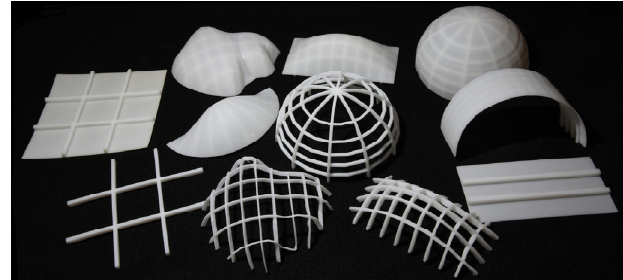
Figure 8. All of the 3D printed models. Table 3. Total stiffener volume and maximum von Mises stress in the shells with and without stiff- ening.